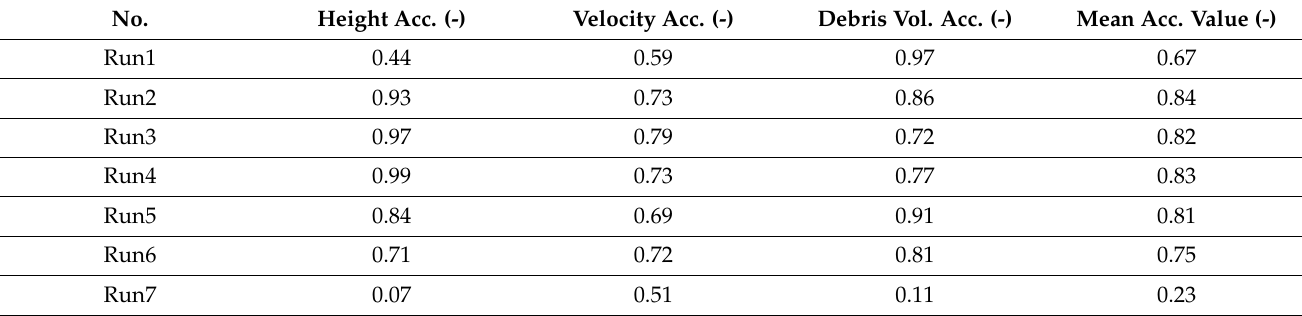
Table 4. Simulation reproducibility (Acc.: accuracy, Vol.: